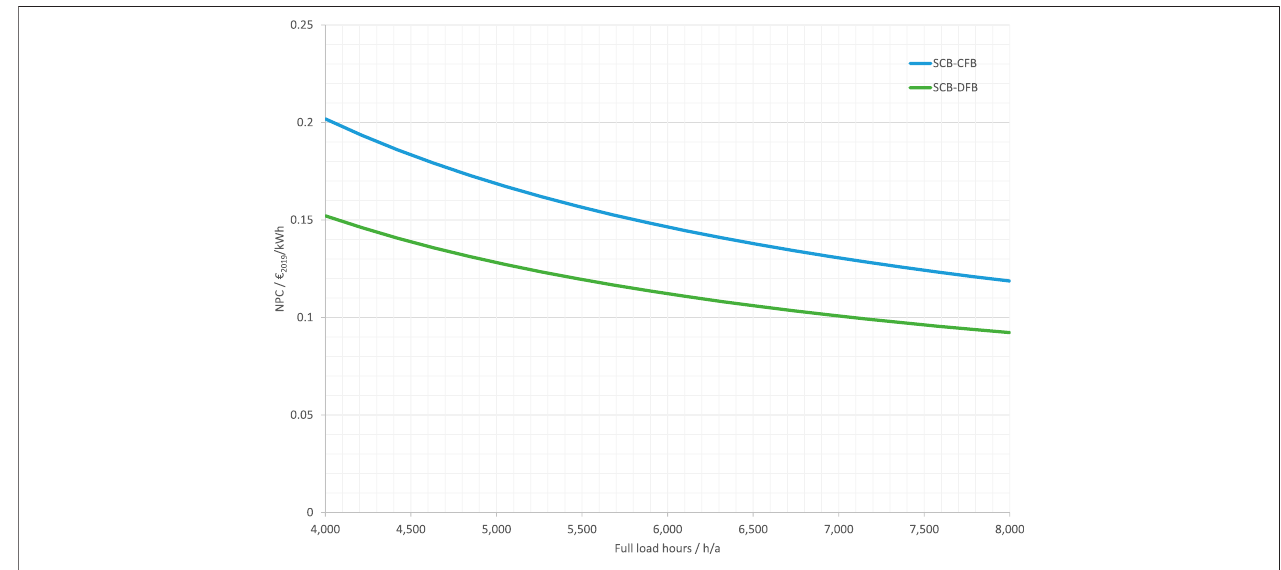
FIGURE 6 | Effect of the operation time on the speci fi c net production costs.